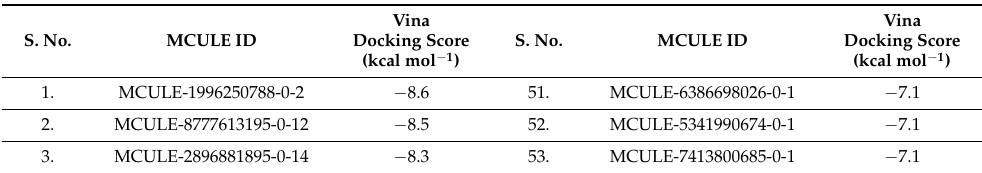
Table 1. List of top 100 ligands identified by screening MCULE’s purchasable library using AutoDock